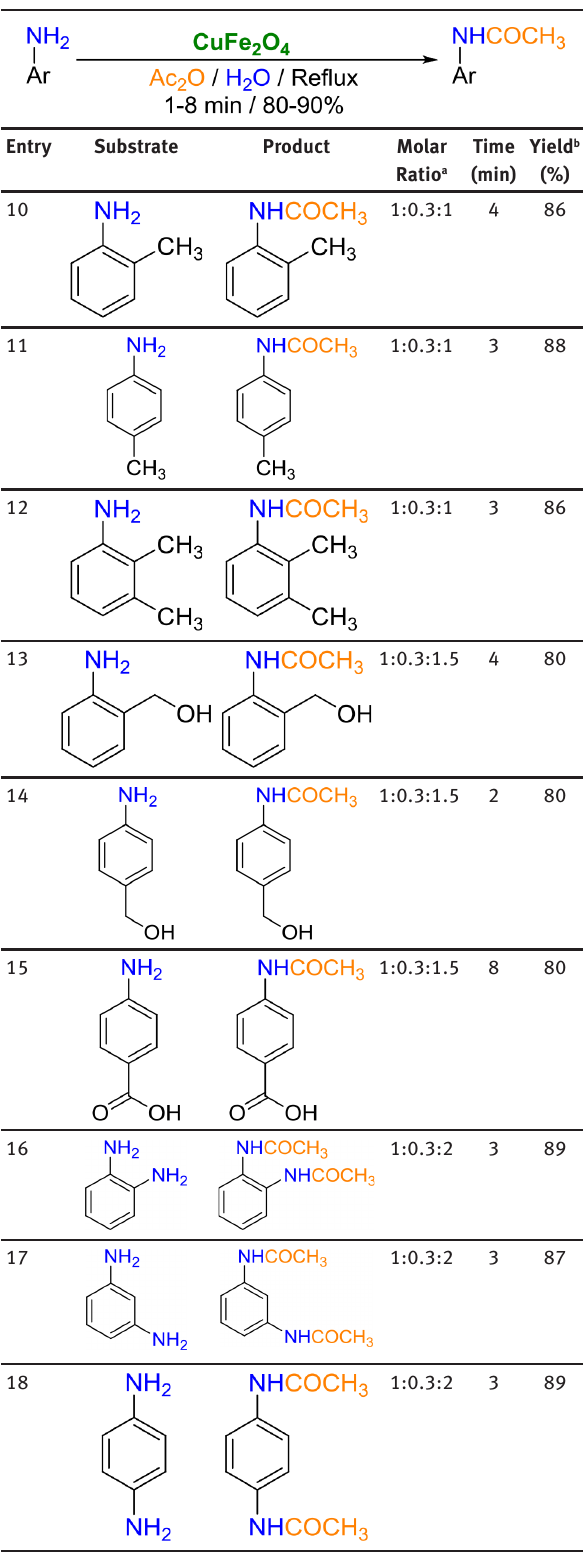
Table 3: Optimization experiments for the one-pot reductive